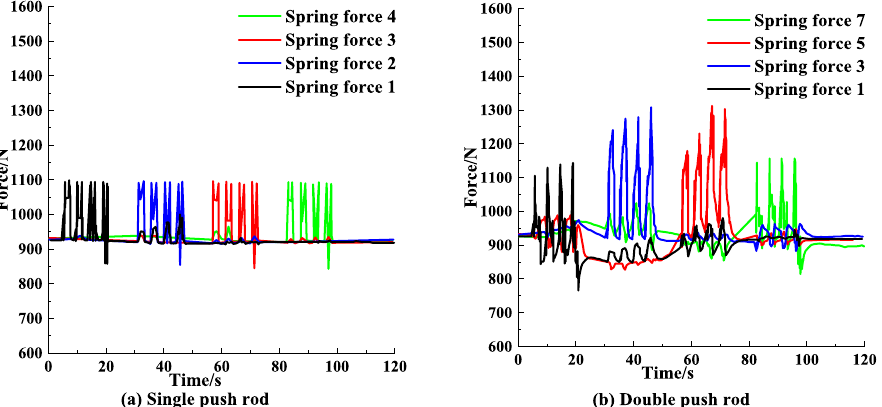
Figure 18. The change of spring force of single push rod support adjustment mechanism, double push rod − double spring support adjustment mechanism when crossing the well wall deposit and casing wear.